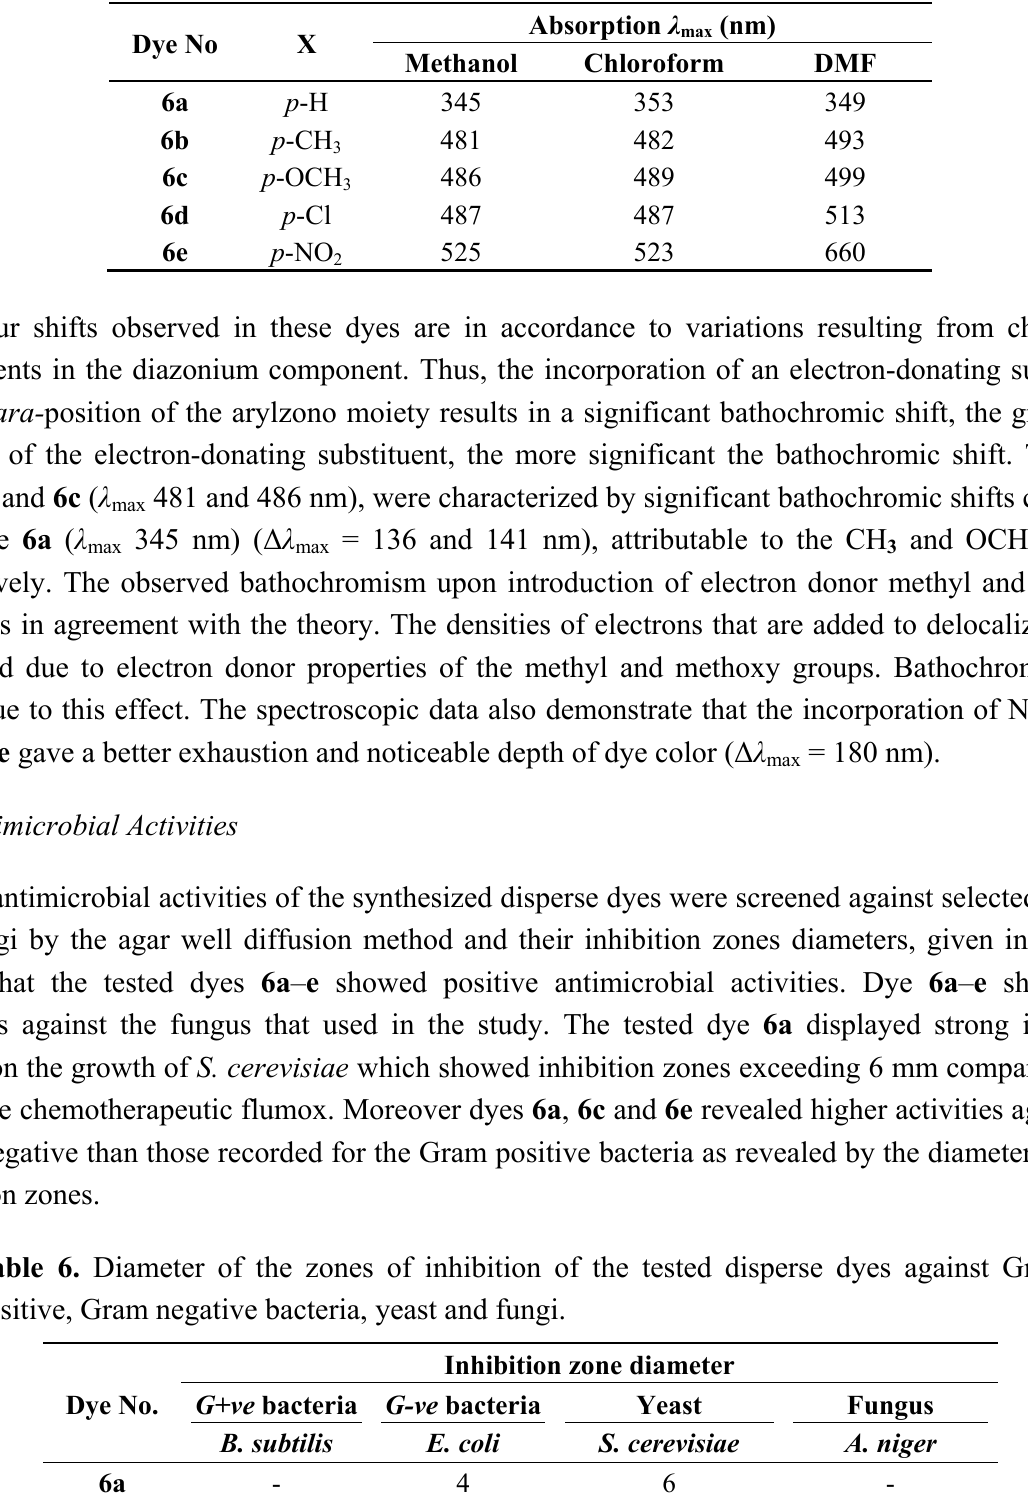
Table 5. Influence of solvent on λ